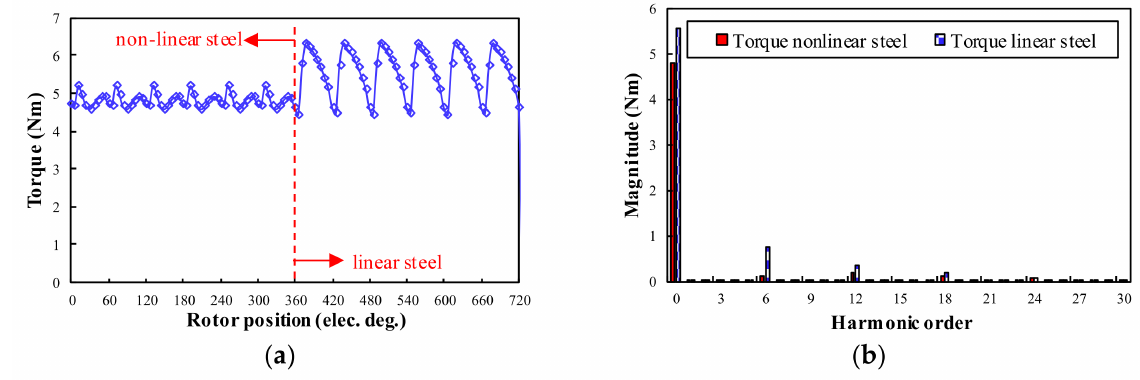
Figure 9. On-load torque waveforms and spectra for 12/4 WRSM: ( a ) Waveforms; ( b ) Spectra.